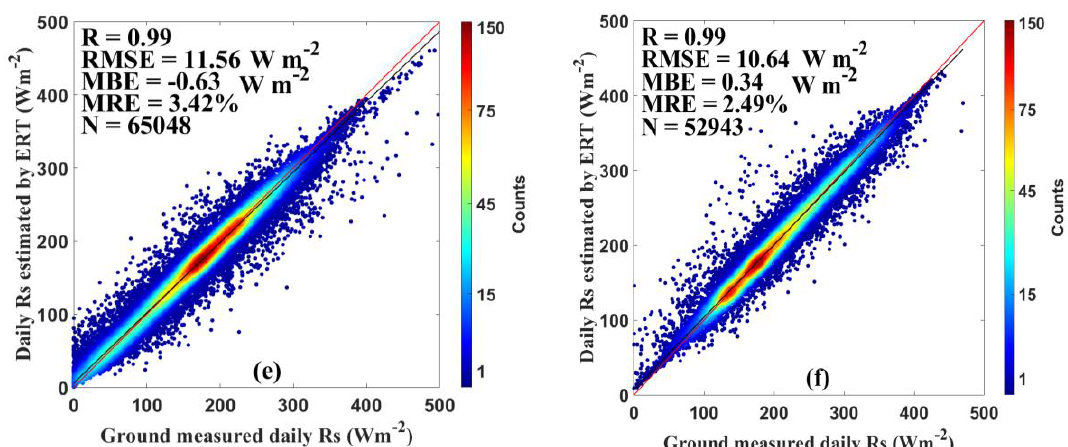
Figure 3. Evaluation results of the ERT-based model in ( a ) northeast China (NE), ( b ) east China (EC), ( c ) north China (NC), ( d ) south China (SC), ( e ) southwest China (SW), and ( f ) Tibetan Plateau (TP) during 2000‒2015.